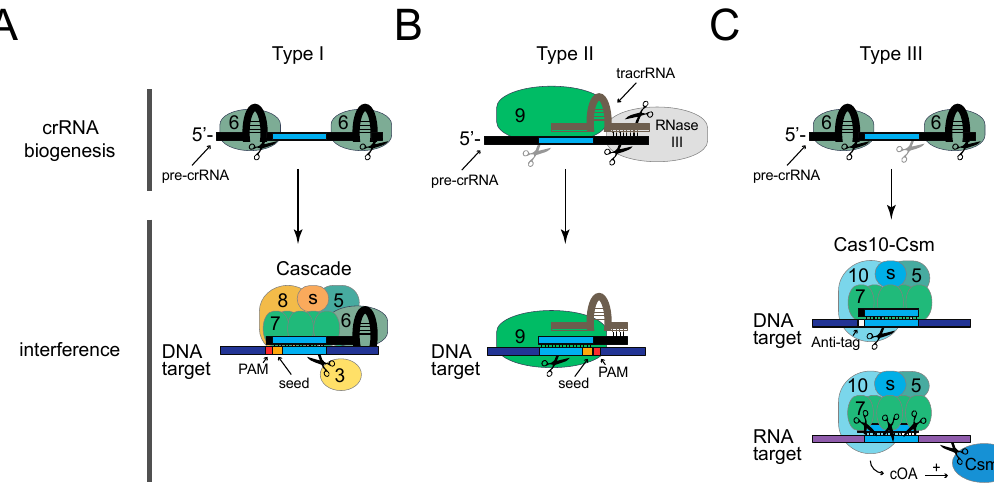
Figure 2. The three main CRISPR–Cas Types that have been successfully used to edit phages. Shown are protein and nucleic acid requirements for crRNA biogenesis and interference steps in representative CRISPR–Cas systems: Type I-E from E. coli ( A ), Type II-A from S. pyogenes ( B ), and Type III-A from S. epidermidis ( C ). Numbered ovals represent corresponding Cas proteins, and “s” represents one or more copies of a small subunit specific to each subtype. Black scissors represent cleavage points made by the overlapping protein subunit, while grey scissors represent cleavage events catalyzed by non-Cas and/or unknown nucleases. For Type I and II systems, the PAM and seed sequences are represented by red and orange rectangles, respectively. For Type III systems, the crRNA tag is represented by a black square, and the opposing anti-tag is shown as a white square. cOA, cyclic oligoadenylates.